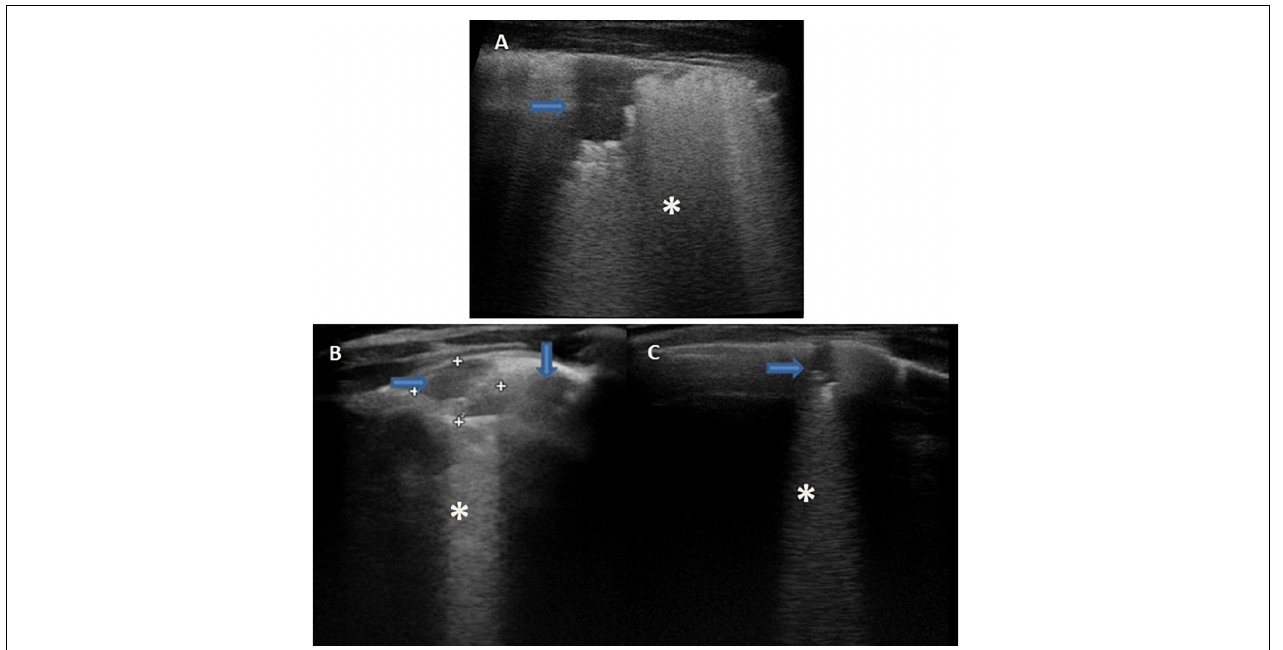
FIGURE 8 | Grayscale lung ultrasound examination (transverse scan between intercostal fields; linear probe with 12 MHz frequency) of children with viral lower respiratory tract infection [ (A) : 2-year-old boy with H1N1 Influenza pneumonia; (B,C) : 8-month-old infant with Respiratory Syncytial Virus bronchiolitis]. Lung ultrasound findings show sonographic interstitial syndrome (SIS) with areas of the white lung with multiple, coalescent vertical artifacts (B-lines, asterisks) and small subpleural consolidations (hypoechoic areas, arrows ) less than 1 centimeter in size associated with areas of “white lung” or confluent B-lines ( asterisks